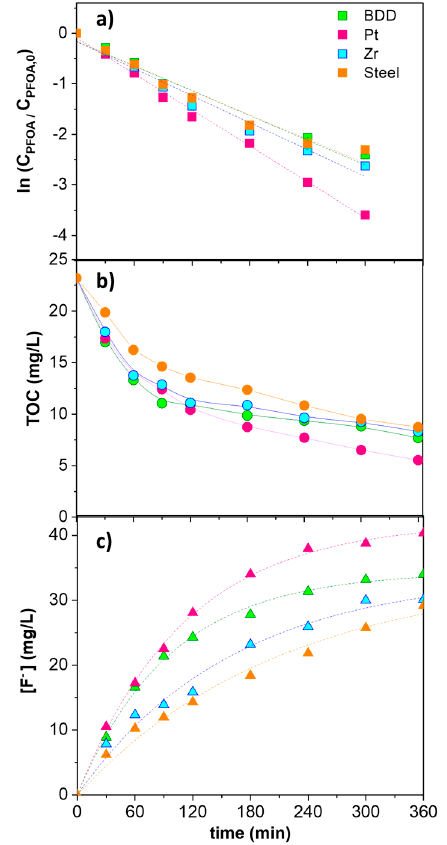
Figure 1. Influence of the cathode material in ( a ) PFOA removal (symbols: experimental data, lines: kinetic fitting), ( b ) TOC depletion, ( c ) released fluorine (symbols: experimental data, lines: kinetic fitting). Operating conditions: [PFOA] 0 : 100 mg/L, j: 7.9 mA/cm 2 , electrolyte: 3.5 mM Na 2 SO 4 , T: 25 °C, pH 0 : 4. Table 2. PFOA degradation and fluoride release kinetics.